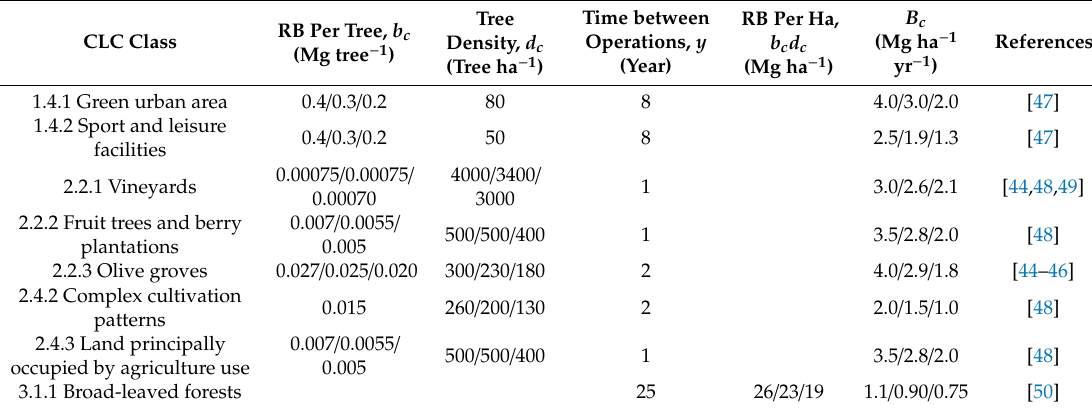
Table 4. Residual biomass density corner values ( B c for c ∈ 1,2,3) estimated for each Corine Land Cover class population. CLC